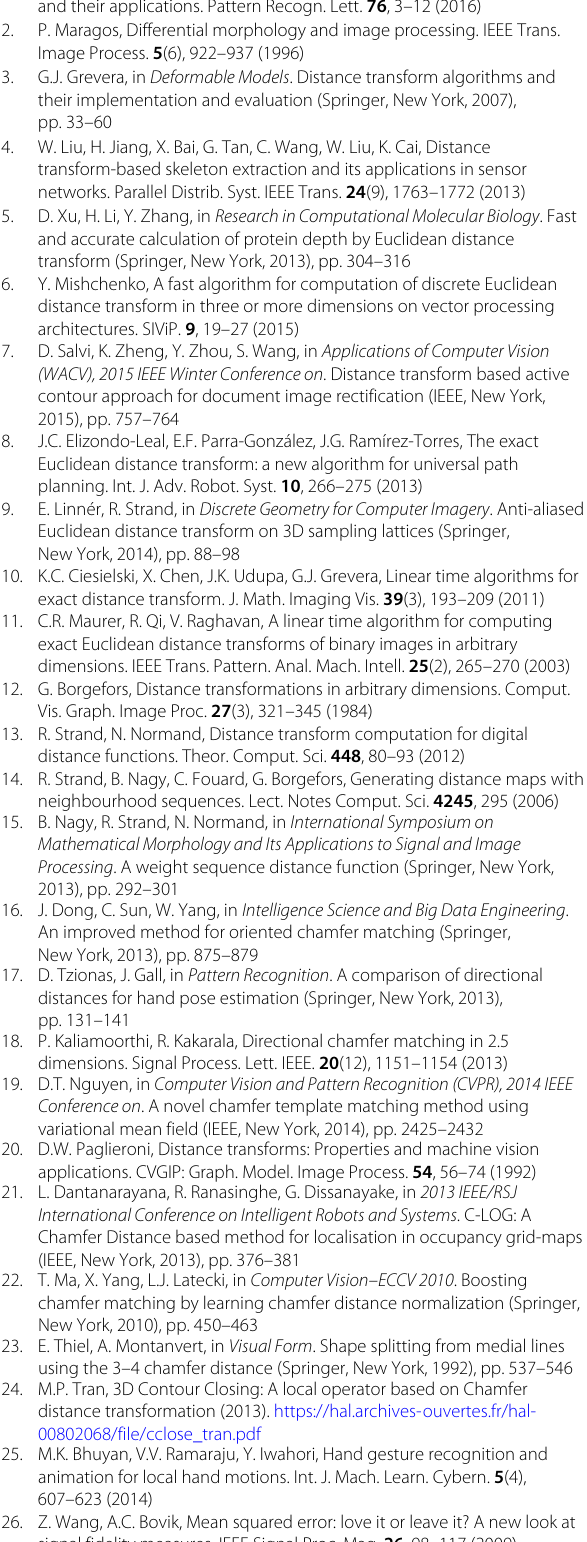
Table 3 Values of β and γ for different kernel sizes Kernel size β